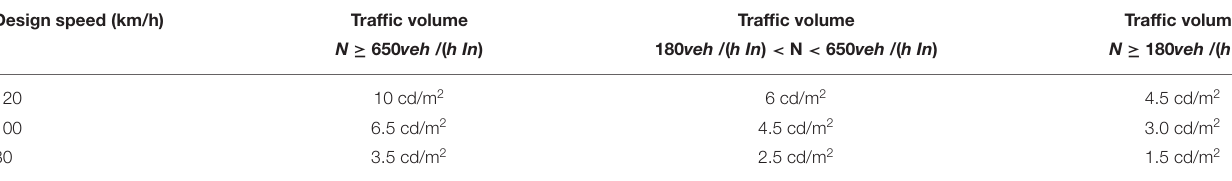
TABLE 1 | JTG/T D70/2-01-2014 about the value of road luminance in the interior zone of tunnel. Design speed